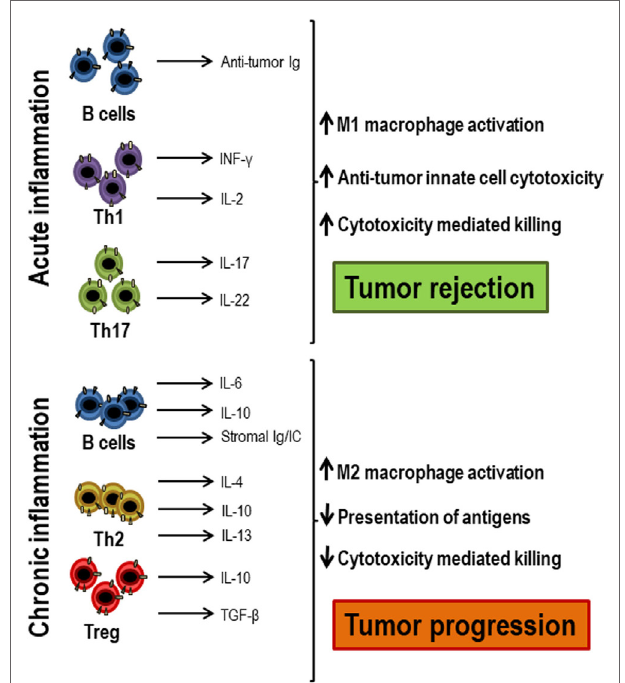
FiGURe 3 | Acute and chronic inflammation participation in antitumor responses. When acute inflammation is activated by tumor cells, Th1 cells secrete antitumor cytokines, such as IFN- γ and IL-2, which, together with antitumor antibodies produced by B lymphocytes, exert an antitumor response and lead to tumor rejection, attracting innate immune cells and cytotoxic T lymphocytes. However, when chronic inflammation occurs in response to tumors, there is often an increase in regulatory T lymphocytes, Th2 cells, and activated B lymphocytes that secrete growth factors, such as IL-4, IL-6, IL-10, IL-13, TGF- β , and immunoglobulins that decrease both antigenic presentation and the activation of cytotoxic cells, favoring tumor